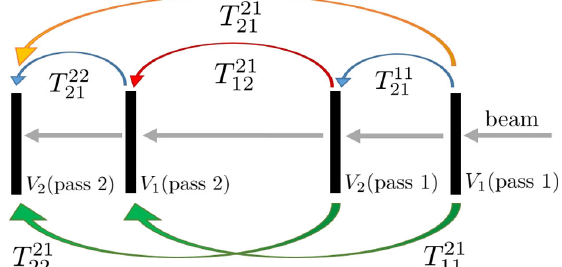
FIG. 16. Illustration of the case C configuration. V j denotes the HOM of cavity j , and T IJ ij is the T 12 from HOM j of pass J to HOM i of pass I . Arrows with the same color indicate that the corresponding T IJ ij are assumed the same in order to derive Eq. (18).